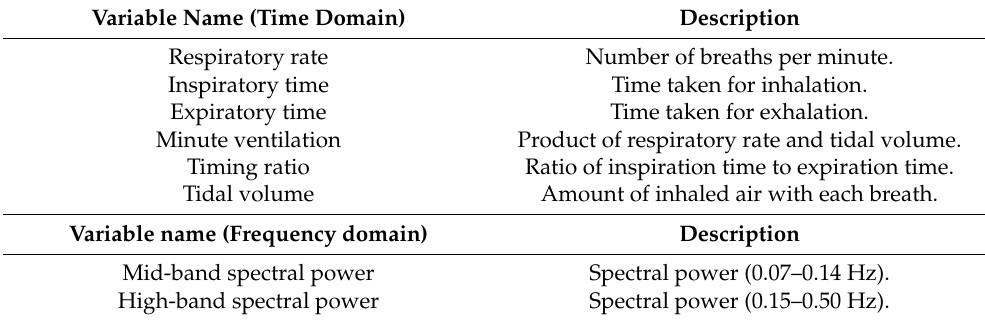
Table 2. Time and frequency domain components of